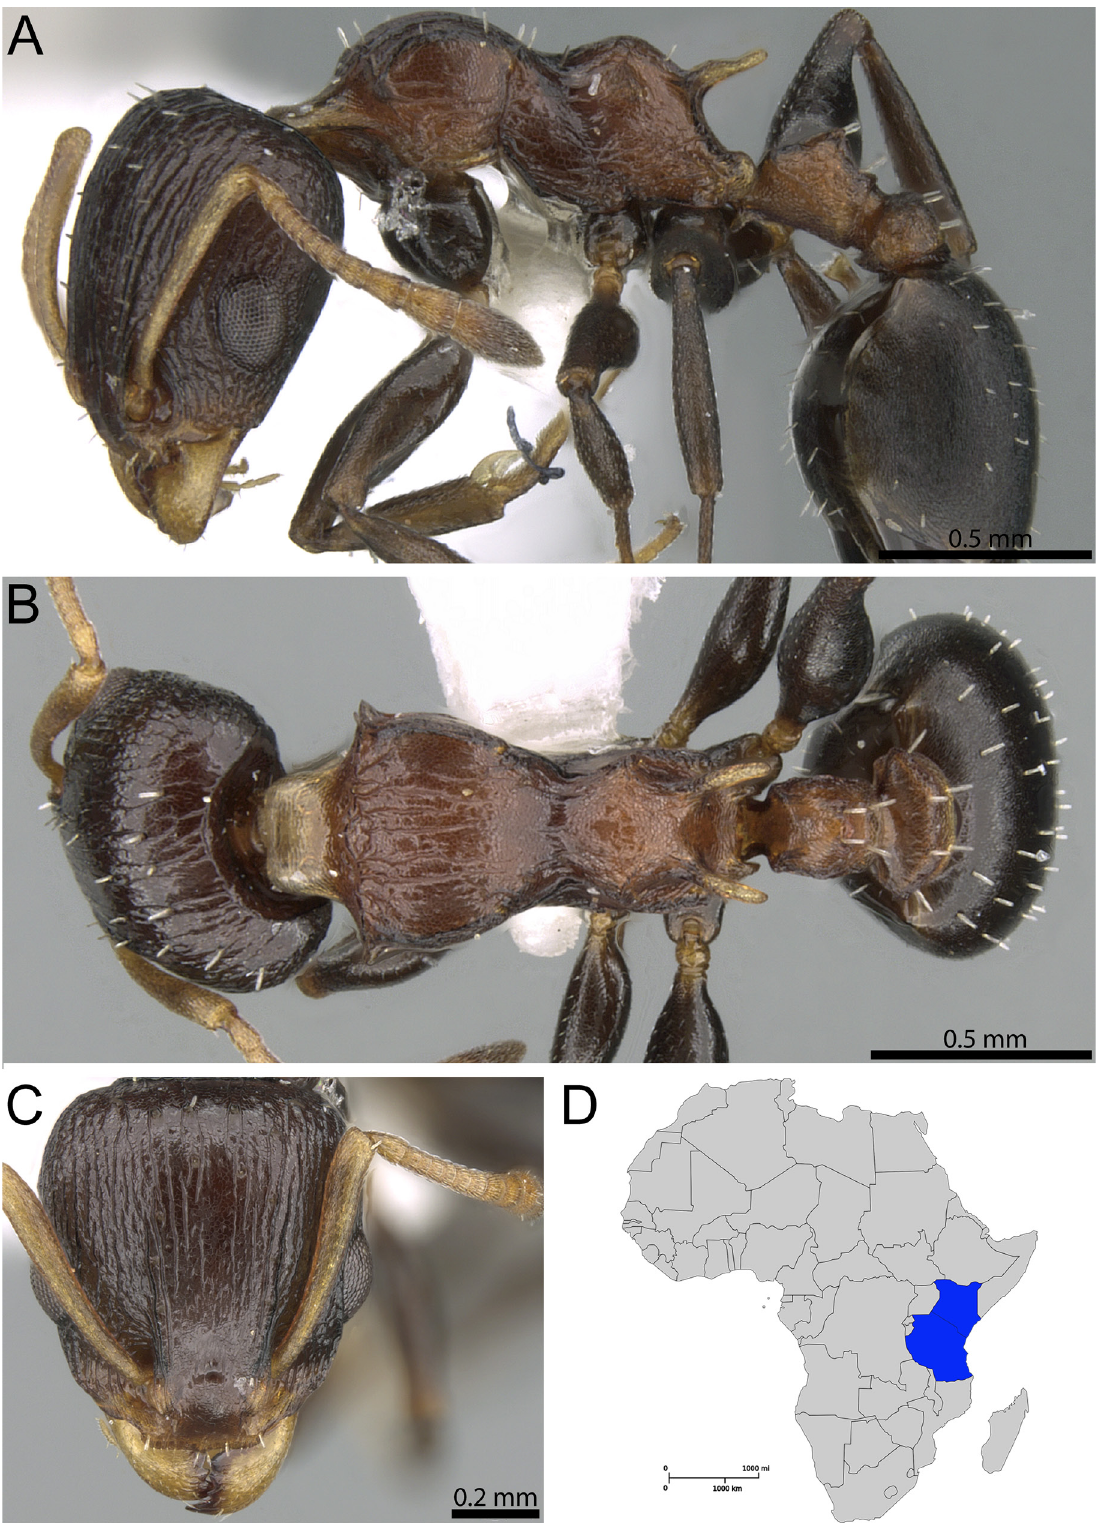
Fig. 6. Nesomyrmex humerosus (Emery, 1896) (CASENT0906196). A . Body in profile view. B . Body in dorsal view. C . Head in full-face view. D. Map of Africa and Madagascar showing currently known